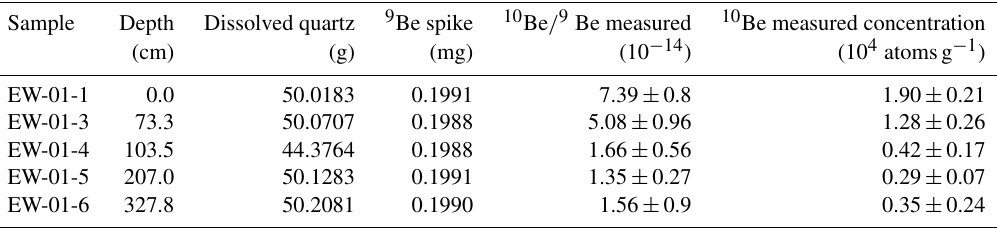
Table A1. Measured 10 Be / 9 Be ratios and 10 Be concentrations for samples of depth profile EW-01. 10 Be concentrations were adjusted using a weighted long-term average blank ratio of 2 . 48 × 10 − 15 , amounting to corrections of between 3 and <19 % (see discussion in text).